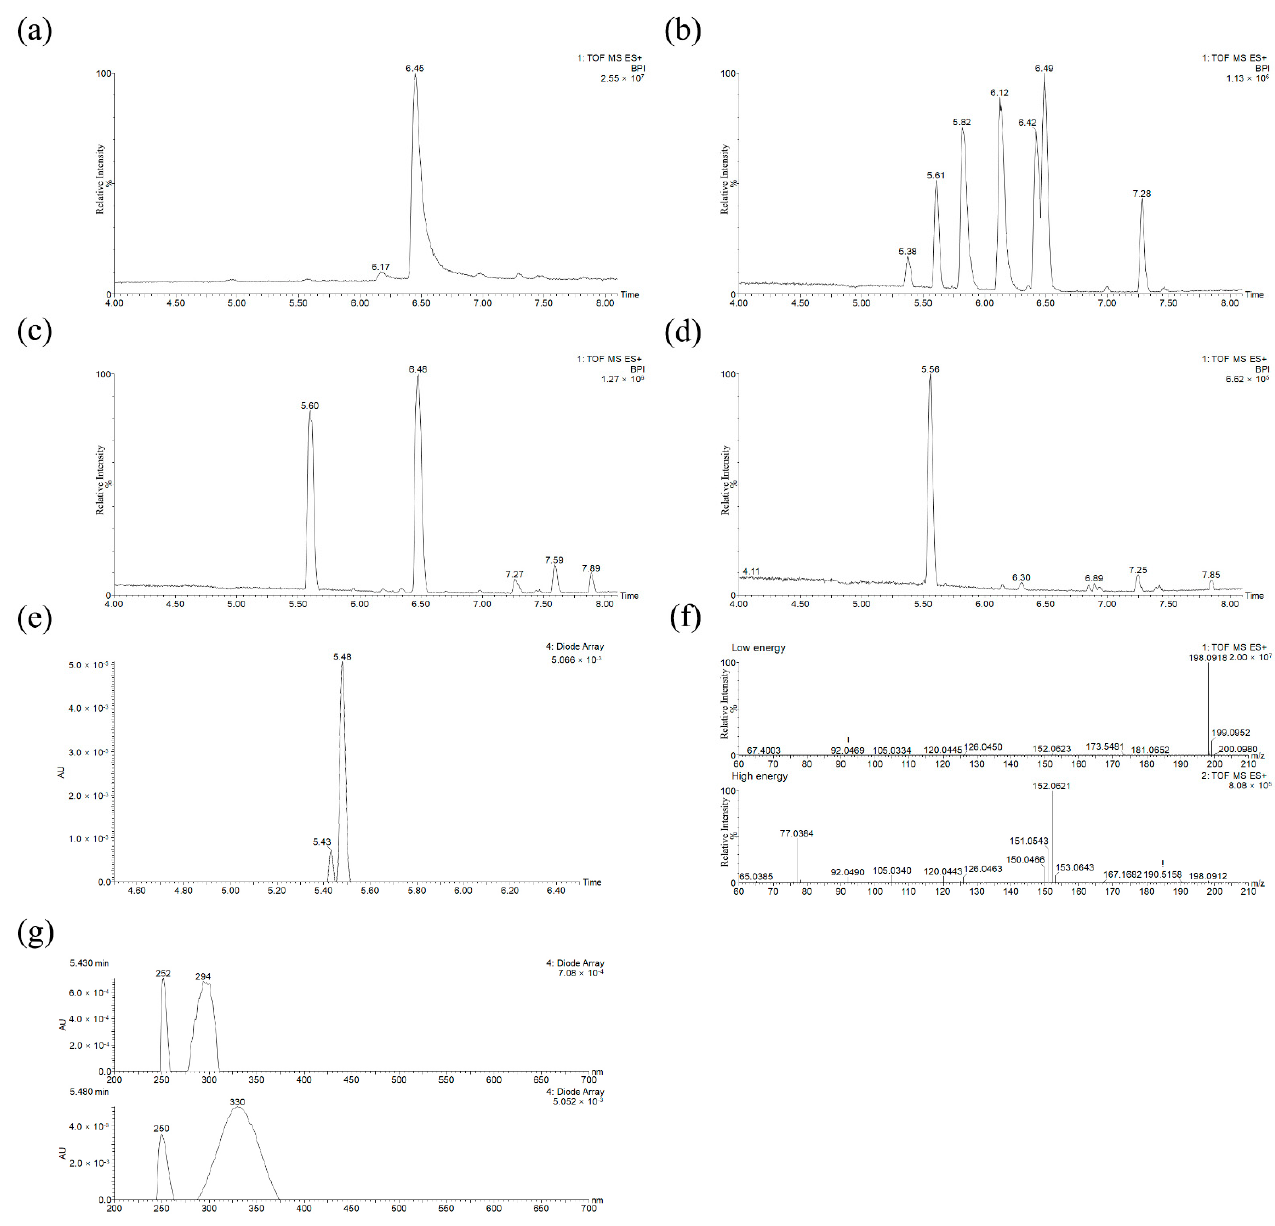
Figure 7. MG representative chromatograms by UPLC-ESI-QTOF MS in a positive ion mode under different aging time: ( a ) K0, 0 h; ( b ) K26, 72 h; ( c ) K27, 78.5 h; ( d ) K28, 96 h; ( e ) co-elute liquid chromatogram; ( f ) MS spectra with an MS E of low and high energy under an RT of 5.56 min; and ( g ) UV–Vis absorbance spectra under an RT of 5.43 and 5.48 min (offset 0.08). N-demethylation, as the main reaction under the photo-kinetics simulated